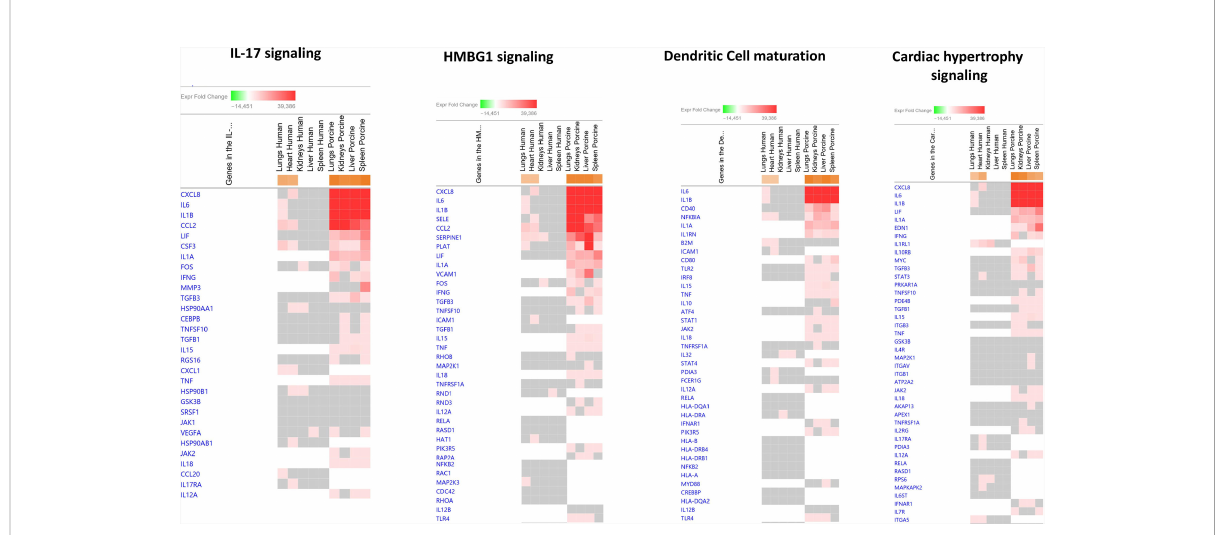
FIGURE 2 Predicted gene signaling pathways from the top upregulated canonical pathways in FFPE tissue samples from patients with meningococcal septic shock and in organs from porcinis infused with exponentially increasing numbers of N. meningitidis (reference strain H44/76) vs. controls. The Z-score indicates predicted activation state of canonical pathways in the tissue samples from meningococcal septic shock patients vs. controls and in organs from porcinis infused with exponentially increasing numbers of N. meningitidis (reference strain H44/76) vs. controls. Orange or lighter shades of orange indicate a positive Z-score and upregulation of the pathway. The transcripts in the gene signaling pathway are expressed as fold change (FC) values. Red or lighter shades of red indicate positive FC-values and upregulation of transcripts; green color or lighter shades of green indicate negative FC-values and downregulation of transcripts. The color gray indicates that a predicted activation state of a gene/transcript in the canonical pathway signaling network is not affected, the gene/transcript was in the dataset but did not pass the analysis cutoffs. White color indicates that gene/transcript are not present in the dataset.